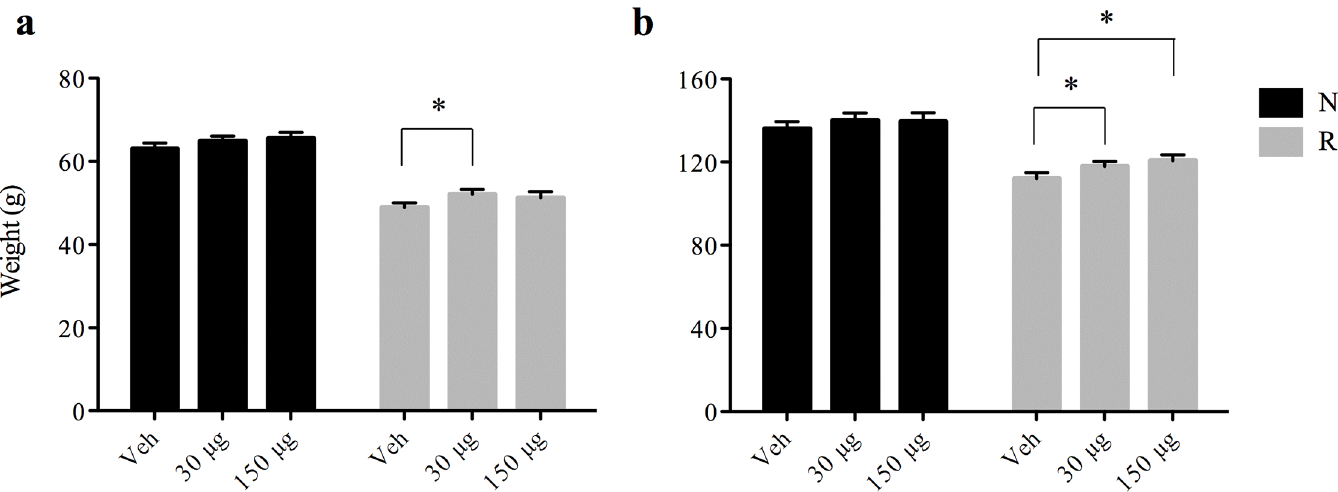
Fig 1. Effect of iron supplementation on weight at PD22 and PD32. ( a ) At PD22 the weight of pups receiving30 μ g of Fe was significantly higher (52.09 ± 0.19 g vs. 48.87 ± 1.1 g, p < 0.05) than controls (Veh) in growth-restricted rats. ( b ) At PD32, the weights of the pups receiving30 μ g and 150 μ g of Fe/day were significantly larger than those receivingvehicle(Veh) ( p < 0.05) using one-wayANOVA. Data are presented as means ± SEM. In black are normalrats, and in grey are growth-restricted rats.